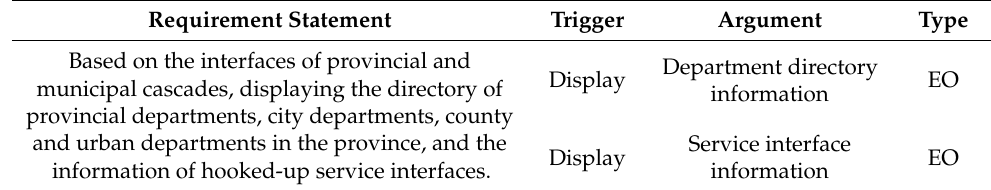
Table 3. Construction of attribution dataset.